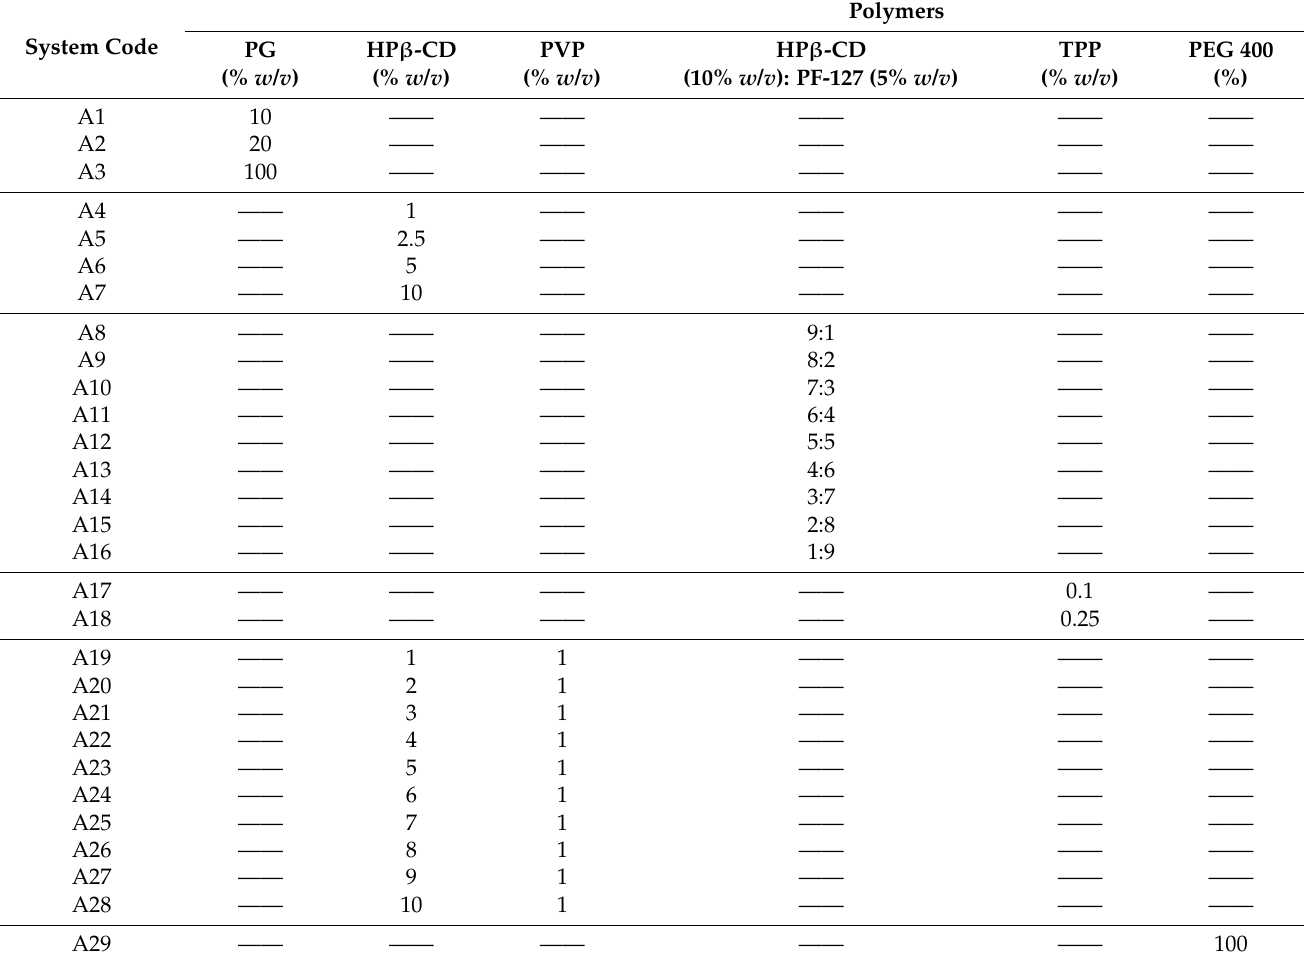
Table 1. Different systems that were used in the determination of MLX solubility at 37 ◦